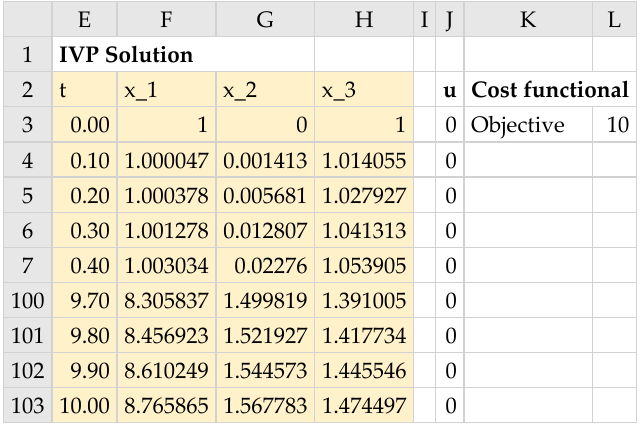
Figure 22. Answer Report generated by Excel’s Solver for optimal control problem (31)–(36).